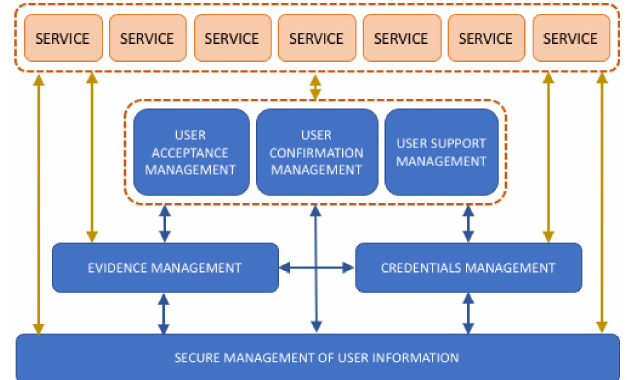
Figure 2. Graphic overview of a reference service-based architecture proposed as a formalization of the User-Centered security